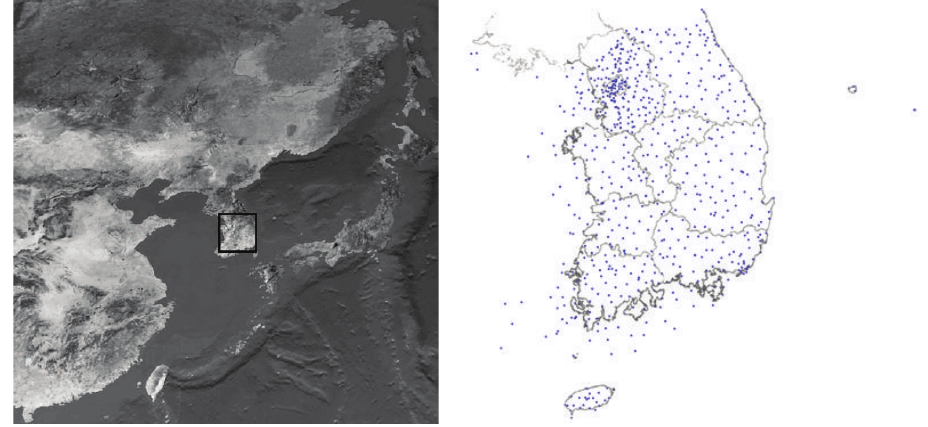
Figure 1: The location of South Korea in East Asia and the dispersion of automatic weather stations in South Korea.